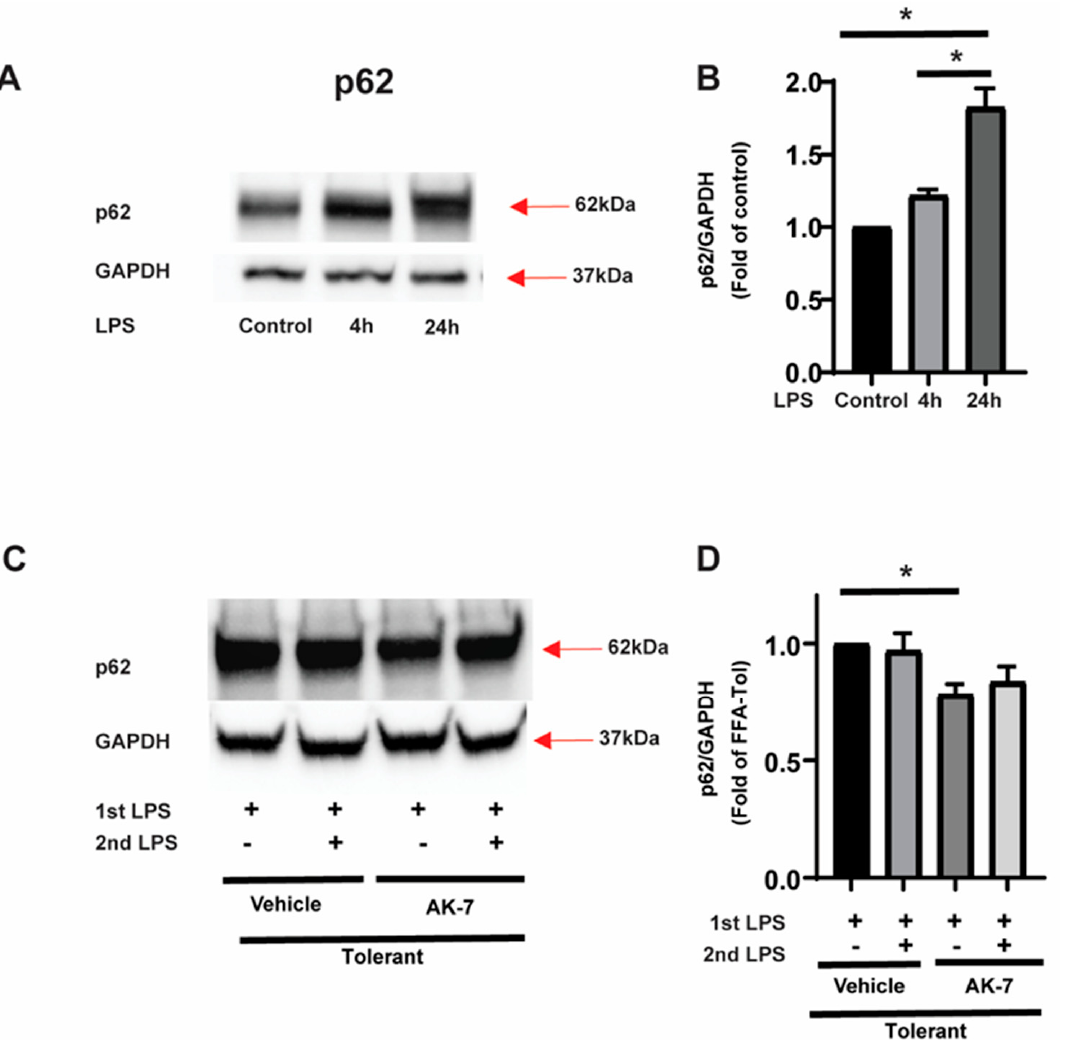
Figure 4. p62 expression in sensitive and tolerant macrophages. Stearic acid (free fatty acid: FFA)-exposed sensitive and tolerant RAW264.7 cell macrophages (RAW) were stimulated with or without LPS for 4 h or 24 h. Loading control: GAPDH. ( A ) p62 protein expression was detected in the cytosolic extract by Western blot. ( B ) Western blot image quantification using image-J software (n = 5 blots; * p < 0.05). ( C ) FFA-exposed tolerant RAW cells were treated with SIRT2 inhibitor AK-7 (25 µ M) or vehicle (DMSO; equal volume) and incubated further for 20 h and stimulated with or without LPS as indicated. p62 protein expression was detected in the cytosolic extract by Western blot. ( D ) Western blot image quantification of p62 using image-J software (n = 5 blots; * p <